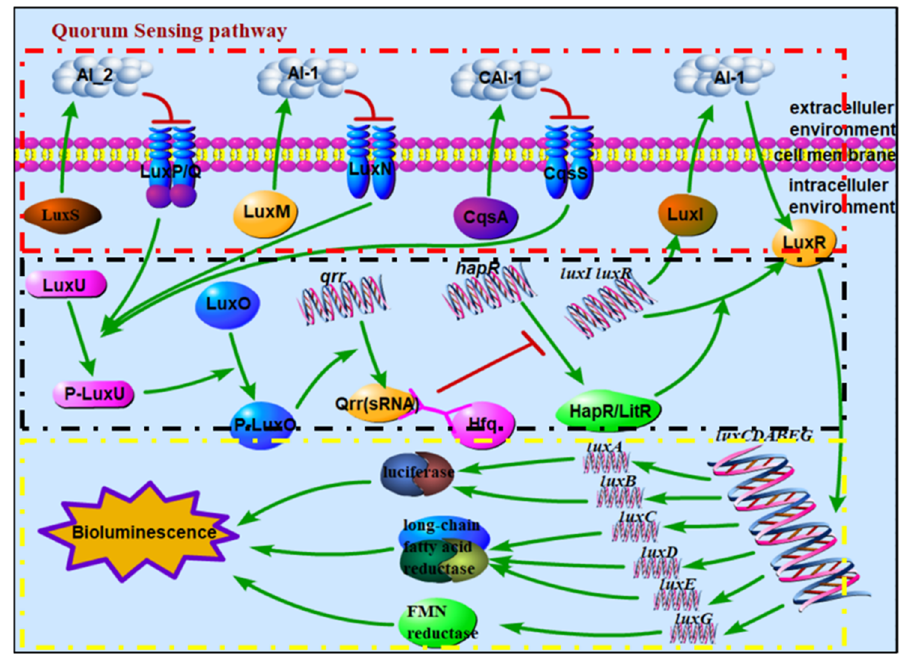
Figure 1. Schematic diagram of signal transmission among related proteins in QS signaling pathway, where the red box refers to autoinducer synthetase sensors, the black box refers to the phosphor-transfer regulation pathway, and the yellow box refers to the mechanism of bioluminescence regulation. (Note: there are LuxS/LuxPQ and CqsA/CqsS in V. cholerae ; LuxM(AinS)/LuxN(AinR), LuxS/LuxPQ, and CqsA/CqsS in V. harveyi ; and LuxI/LuxR, LuxM(AinS)/LuxN(AinR), and LuxS/LuxPQ in A. fischeri ; HapR in V. cholerae does not regulate bioluminescence, while LitR in A. fischeri . regulates bioluminescence.).